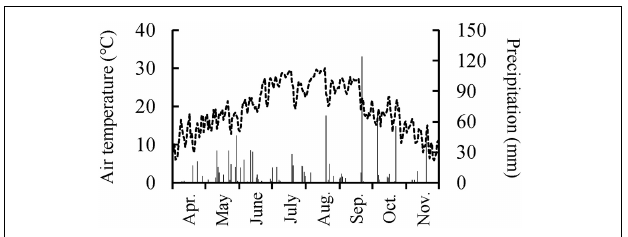
FIGURE 1 | Daily mean air temperature and precipitation in the experimental nursery from April 1st to November 30th, 2011.